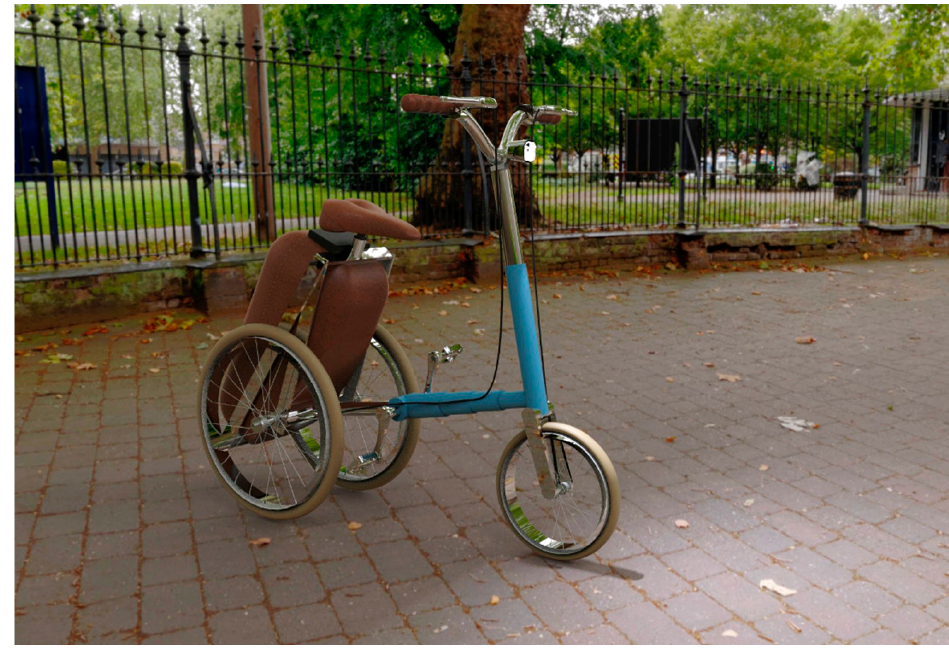
Figure 20. 3D model and rendering.